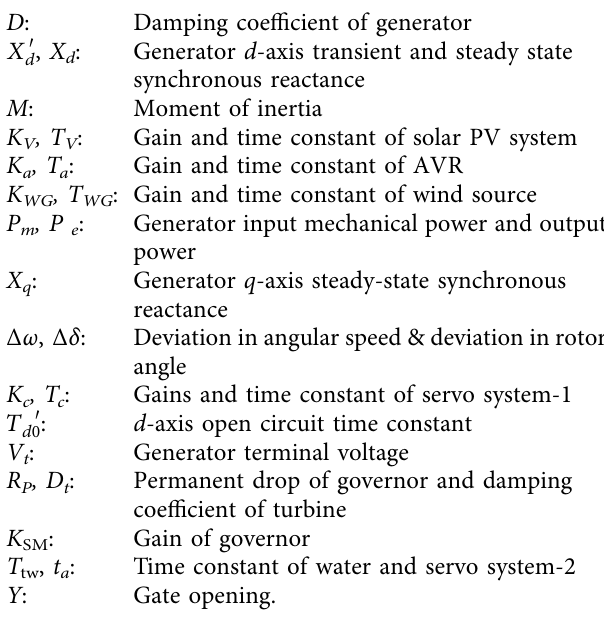
4 , G 5, G 6, and G 7